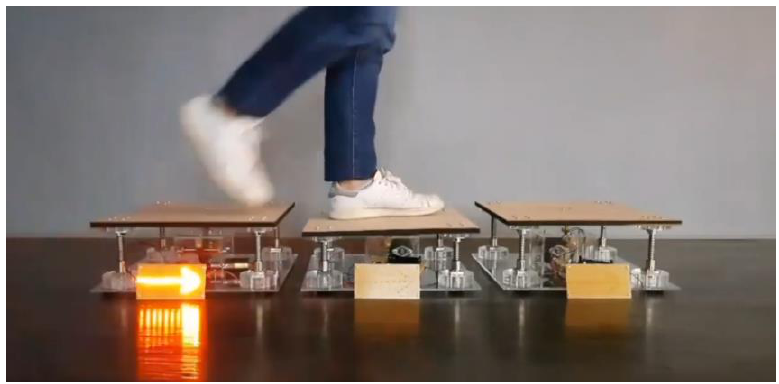
Figure 21. Installation and demonstration.